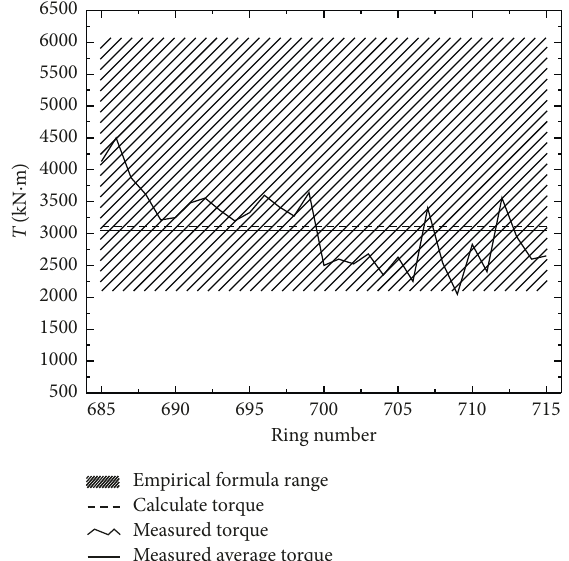
Figure 5: Comparison of total torque during shield cutting